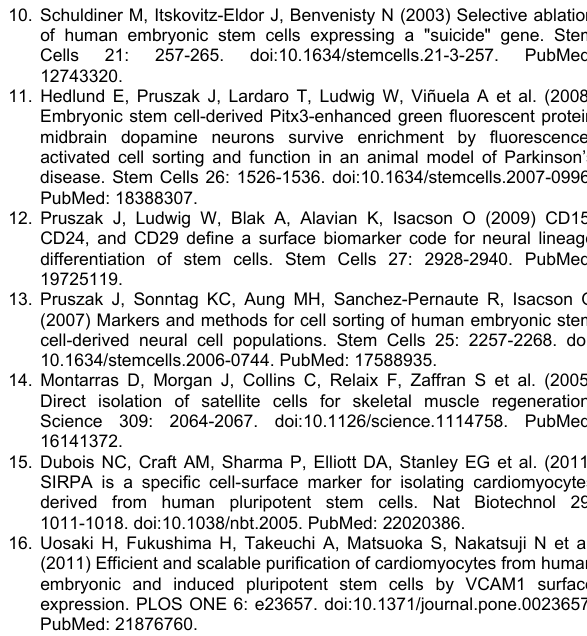
Figure S3. Co-expression scores of surface antigens present on populations of interest as defined by intracellular antigens doublecortin (DCX), β-III-tubulin (TUJ1) and glial fibrillary acidic protein (GFAP). ( A ) Co- expression scores were calculated by determining the ratio of cells (percentage) present in upper right (UR) to lower right (LR) quadrants over the ratio of upper left (UL) to lower left